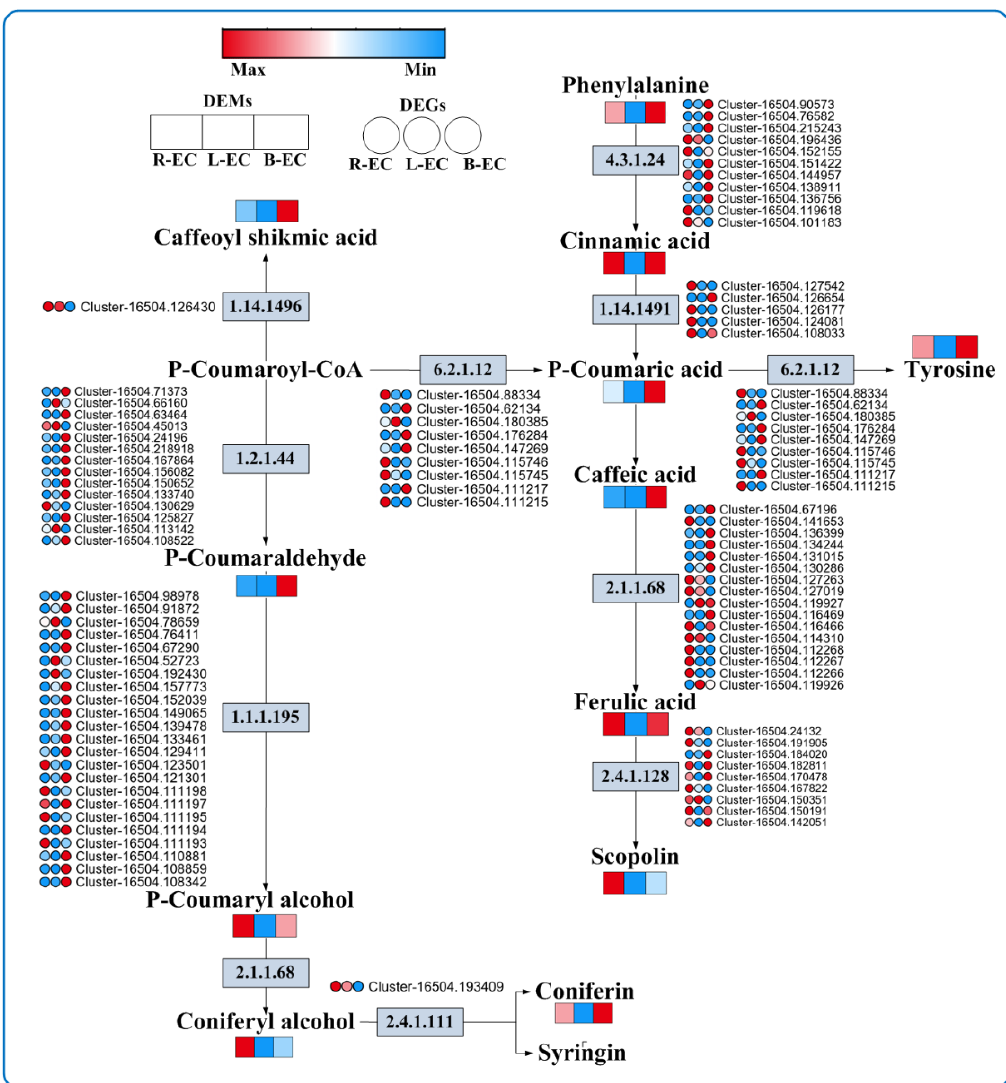
Figure 10. Analysis of DEGs and DEMs of phenylpropane metabolic pathways among Korean pine R-EC, L-EC, and B-EC cell lines. 4.3.1.24: phenylalanine ammonia lyase; 1.14.14.91: trans-cinnamic acid 4-monooxygenase; 6.2.1.12: 4-coumaric acid-CoA ligase; 2.1.1.68: caffeic acid 3-O-methyltransferase; 2.4.1.128: Scopolamine glucosyltransferase; 1.14.14.96: 5-O-(4-coumaroyl)-D-quinic acid 3′-monooxygenase; 1.2. 1.44: cinnamoyl-CoA reductase; 1.1.1.195: cinnamyl alcohol dehydrogenase; 2.1.1.68: caffeic acid 3-O-methyltransferase; 2.4.1.111: coniferyl alcohol glucosyltransferase.